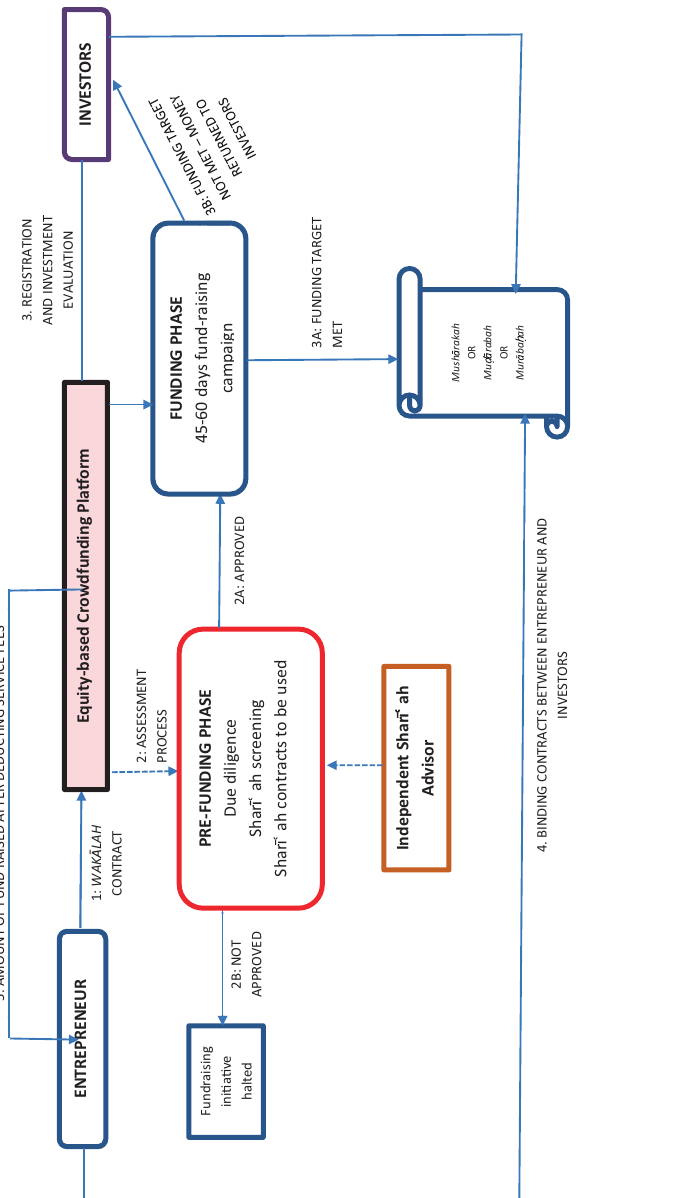
Figure 4. Proposed SEC framework – pre- funding and funding